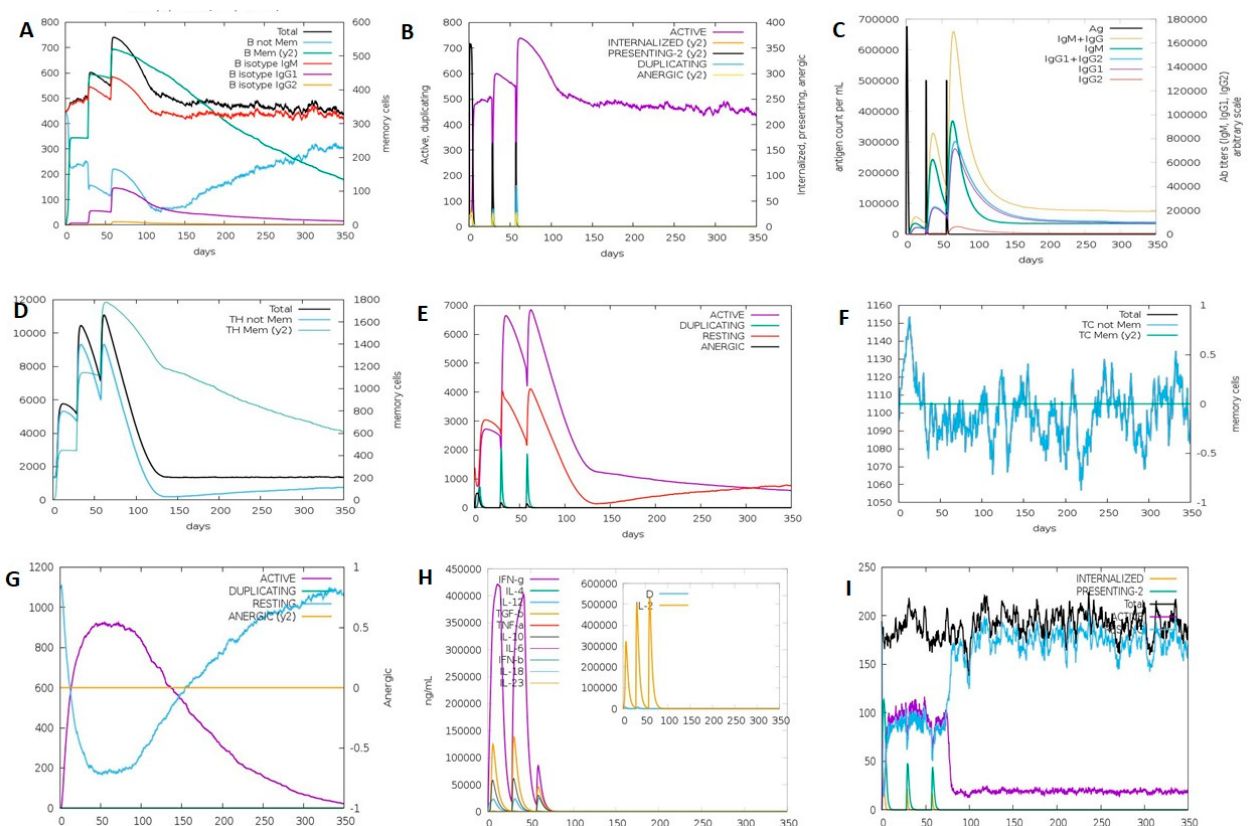
Figure 8. Demonstration of humoral and cellular immune responses using immune simulation. ( A ) B-cell population (cells per mm 3 ). ( B ) B-cell population per state (cells per mm 3 ). ( C ) Antigen, immunoglobulins and immunocomplexes. ( D ) TH cell population (cells per mm 3 ). ( E ) TH cell population per state (cells per mm 3 ). ( F ) TC cell population (cells per mm 3 ). ( G ) TC cell population per state (cells per mm 3 ). ( H ) Concentrations of cytokines and interleukins production. ( I ) Macrophage population per state (cells per mm 3 ).